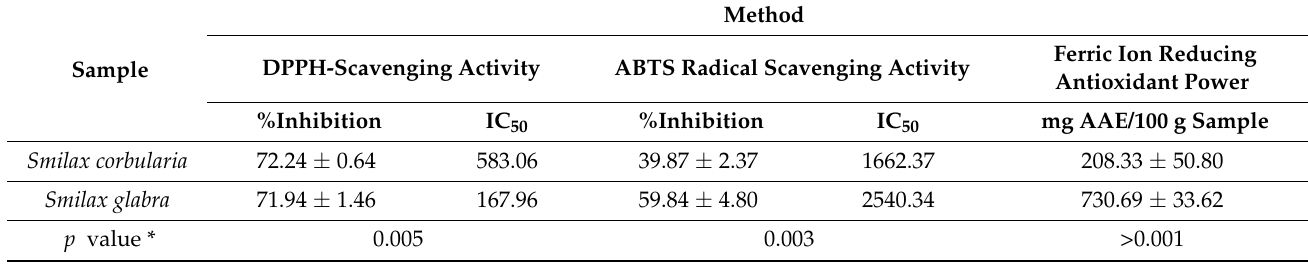
Table 4. DPPH scavenging activity, ABTS radical scavenging activity, and ferric ion reducing antioxi- dant power of the ethanolic extracts of Smilax glabra and Smilax corbularia .